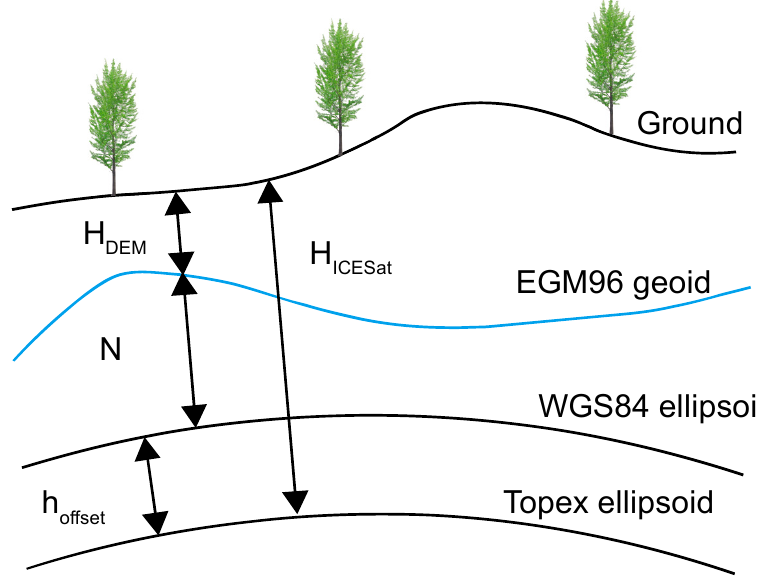
Figure 7. Relationship between the ICESat/GLAH data and the DEM in this study. Therefore, 30 rails ICESat GLAH14 points (5776 in total) were collected (Figure 6a) and converted into the WGS84 ellipsoid, following Bhang et al. [83] as follows: h WGS 84 = h − N − h of fset